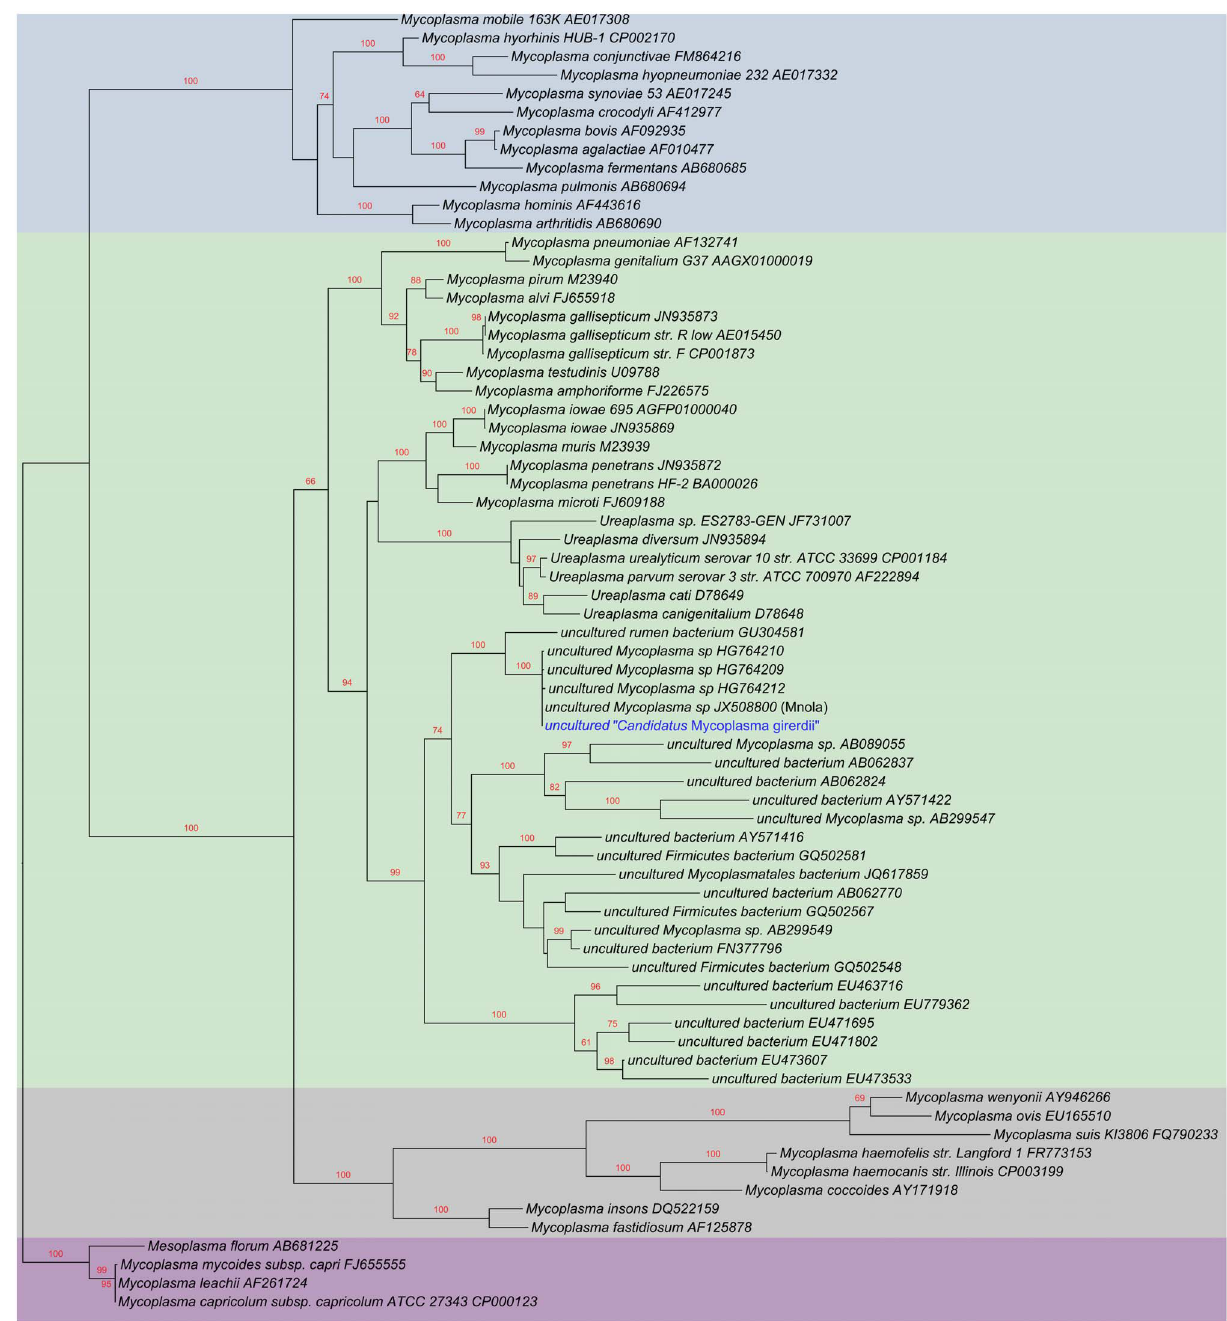
Figure 4. Phylogenetic tree of 16SrRNA shows uncultured ‘‘ Ca. M. girerdii’’ clusters most closely with other uncultivated organisms in the Pneumoniae Group. The maximum likelihood tree was inferred by RAxML 7.2.7 using the gamma-distributed heterogeneity rate categories with 1,000 bootstraps. The 16S rRNA gene alignments were manually inspected. The Hominis Group is shaded in blue, the Pneumoniae Group in green, the Hemoplasma Group in gray and the Spiroplasma Group in purple. The 16S rRNA sequence of ‘‘ Ca . M. girerdii’’ VCU_M1, ‘‘ Ca . M. girerdii’’ VCU_PA1, ‘‘ Ca . M. girerdii’’ VCU JB1 and ‘‘ Ca . M. girerdii’’ VCU_G1 were identical. ‘‘ Ca . M. girerdii’’ groups most closely with ‘‘Mnola’’, which shows 100% identity in 16S rRNA sequence, uncultivated organisms from the oral sample of a low birth weight infant (HG764209, HG764210,